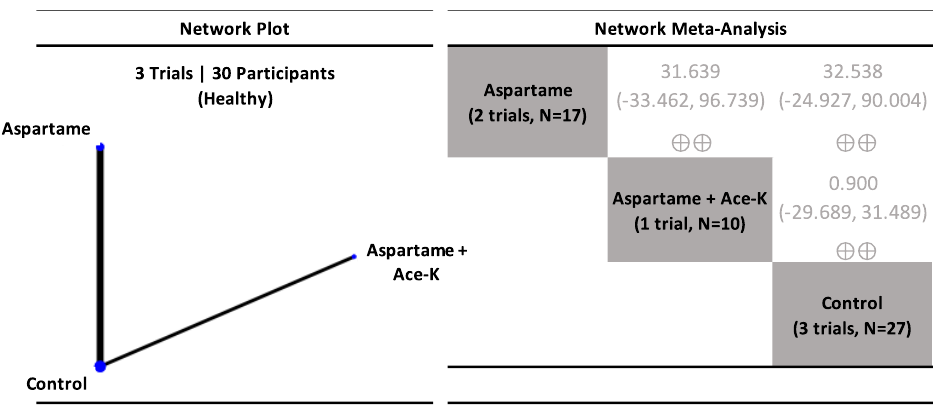
postprandial blood glucose response in participants with type 2 diabetes. Network plot: the size of the blue nodes is proportional to the number of participants and the line width is proportional to the number of studies. Network table: treatments are grouped by treatment type (i.e., individual non-nutritive sweeteners (NNS), NNS blends, water, and caloric sweeteners) and are reported in alphabetical order. Treatment estimates (mmol*min/L) are MDs and 95% CIs of the column-defining treatment compared with the row-defining treatment. MDs less than 0 favor the col- umn-defining treatment. MDs greater than 0 favor the row-defining treatment. Significant results are bolded in black. Non-significant results are grey and not bolded. The minimally important difference (MID) for postprandial glucose response is 100 mmol*min/L. Trivial (significant) effects (<1 MID) or no effects have a white background; small im- portant effects (>1 MID) have a light blue background; moderate effects (>2 MID) have a darker blue background; large effects (>5 to <10 MID) have a purple background; and very large effects (>10 MID) have a black background. Confidence in the effect estimate is shown for each treatment comparison: high confidence ⊕⊕⊕⊕ ; moderate confidence ⊕⊕⊕ ; low confidence ⊕⊕ ; and very low confidence ⊕ . See Supplementary Table S7 and Figures S10 – S13 for detailed assess- ments of the confidence in the effect estimate using the CINeMA framework.